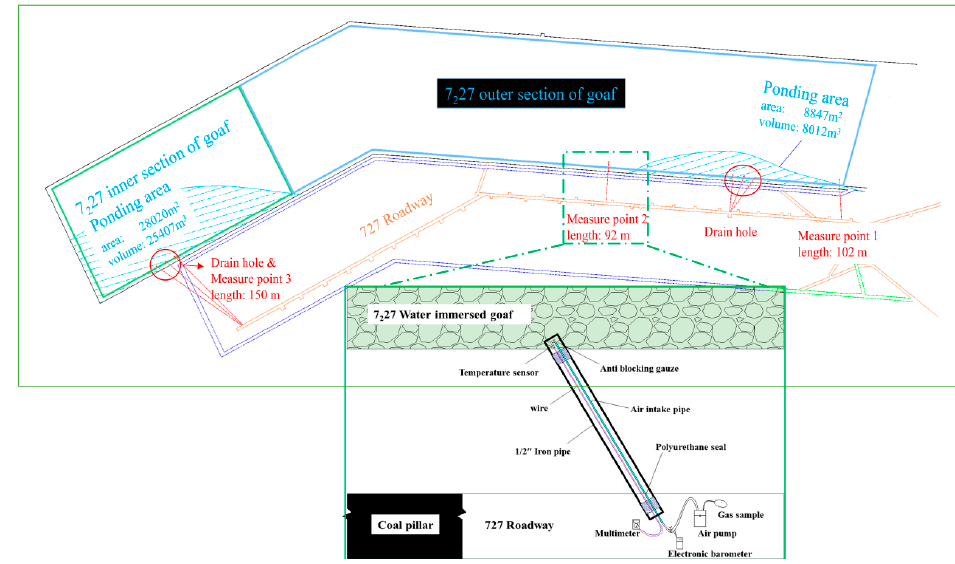
Figure 9. Schematic diagram of establishment of the on-site monitoring system.